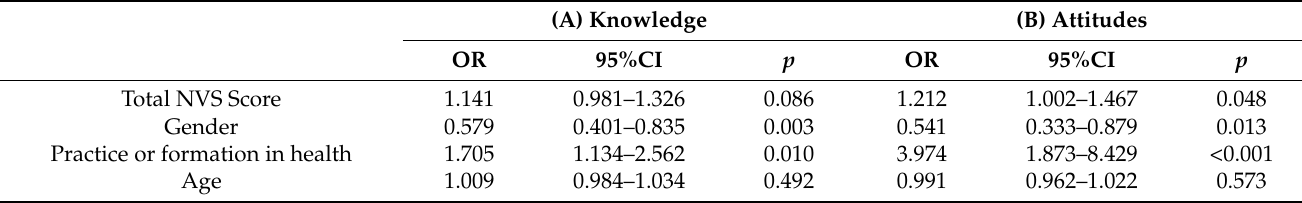
Table 3. Relation between ( A ) knowledge or ( B ) attitudes towards COVID-19 and literacy for health, adjusted for age, gender, and practice or formation in